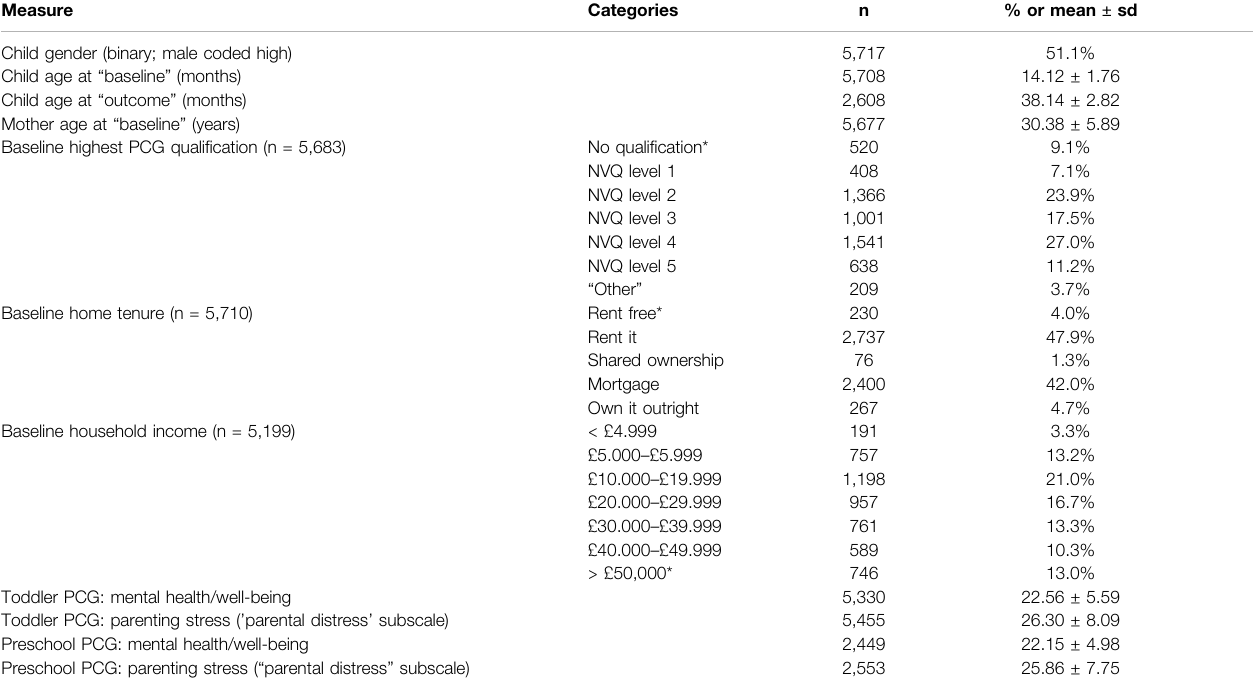
TABLE 2 | Descriptive statistics for the additional measures included in this study. Measure Categories Child gender (binary; male coded